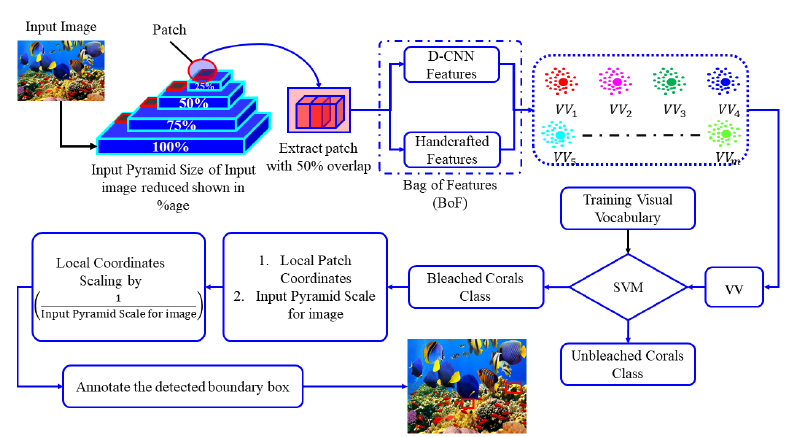
Figure 9. Bleached Corals Positioning